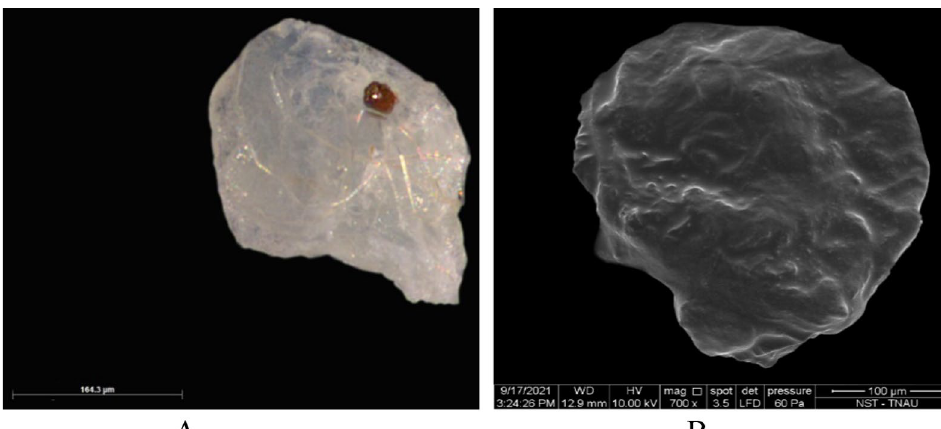
Fig. 5 A, B Second instar larva of T. remus